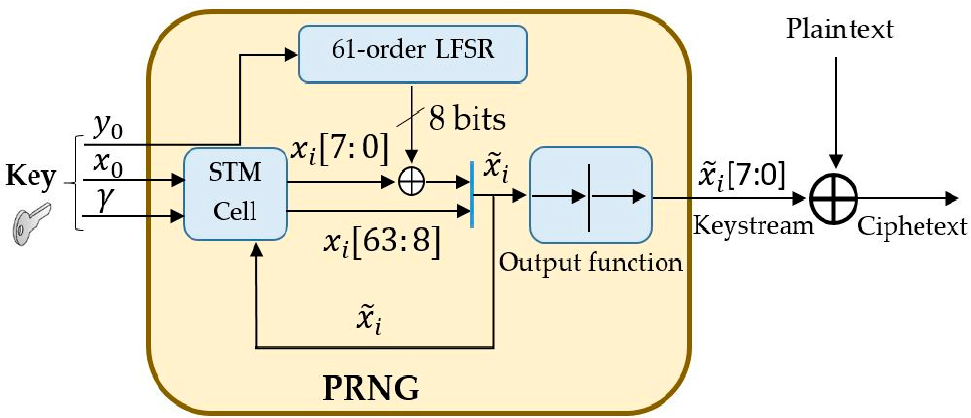
Figure 3. Scheme of the proposed stream cipher. The eight least-significant bits (LSBs) of each state, x i , are XORed with the last 8 bits generated by a 61-order linear feedback shift register (LFSR). These bits are the ones used to generate the keystream. On the other hand, the resulting modified state, (cid:101) x i , obtained by recombining these eight modified bits with the 56 remaining bits is used as an input of the STM block. This block applies the STM equations as explained in Figure 2 to generate the next state, x i + 1